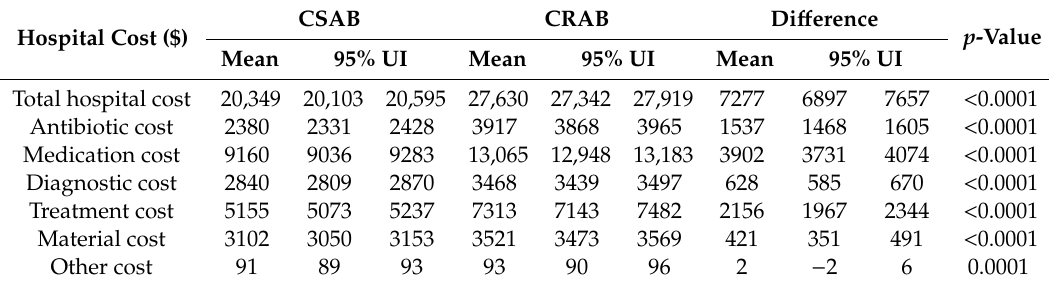
Table 6. Economic costs of patients with CRAB and CSAB after PSM for potential confounding